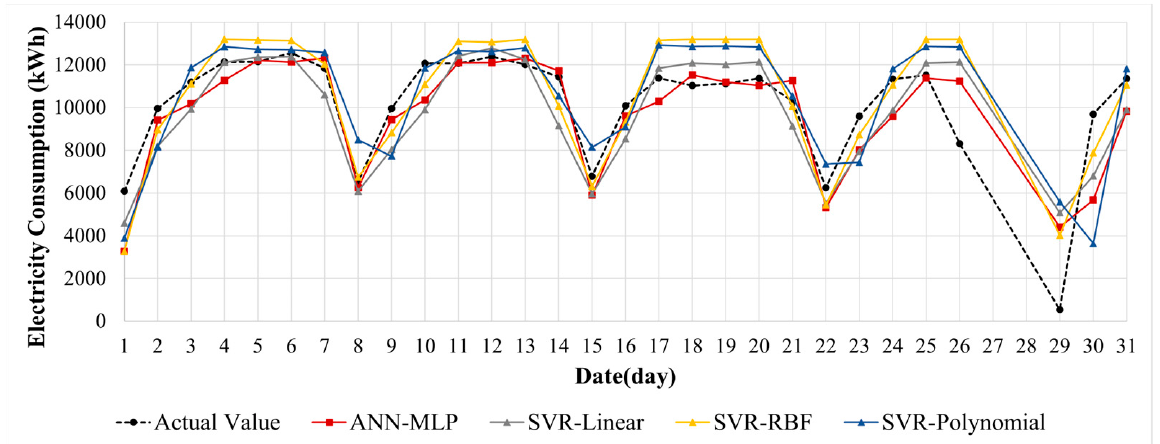
Figure 11. Comparison of the measured and predicted values for electricity consumption (1 to 31 January 2017).